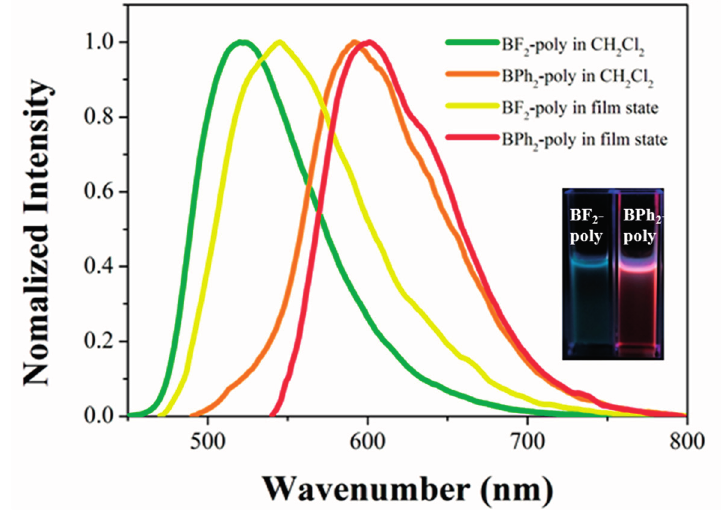
-poly and BPh -poly in CH 2 Cl 2 and the solid 2 2